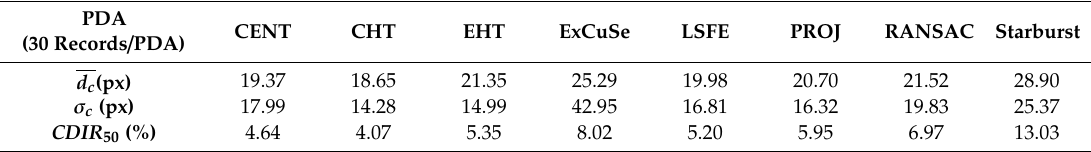
Table 3. Mean value and standard deviation of the Euclidean distance for cluster evaluation and CDIR 50 for all tested PDAs in the scene image.